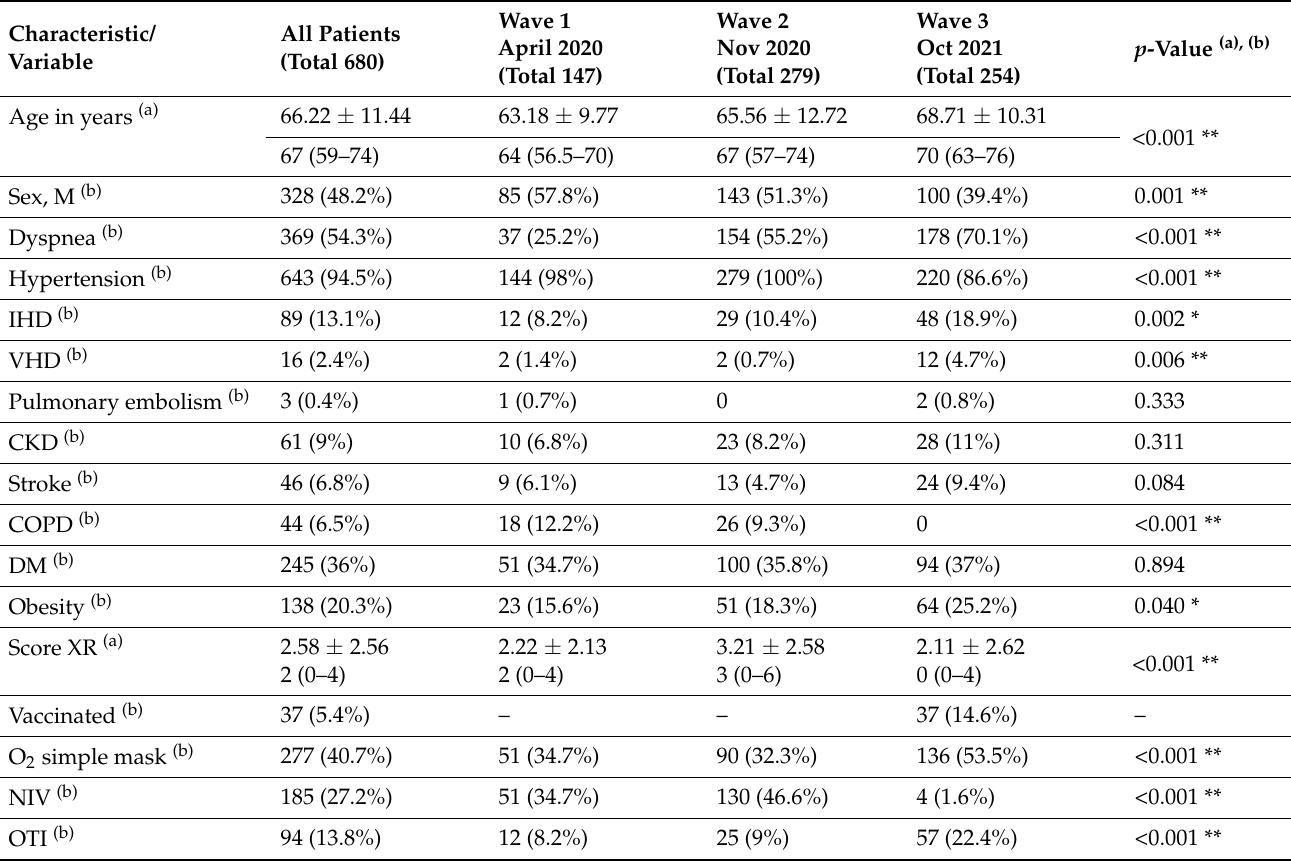
Table 1. Study participants: descriptive